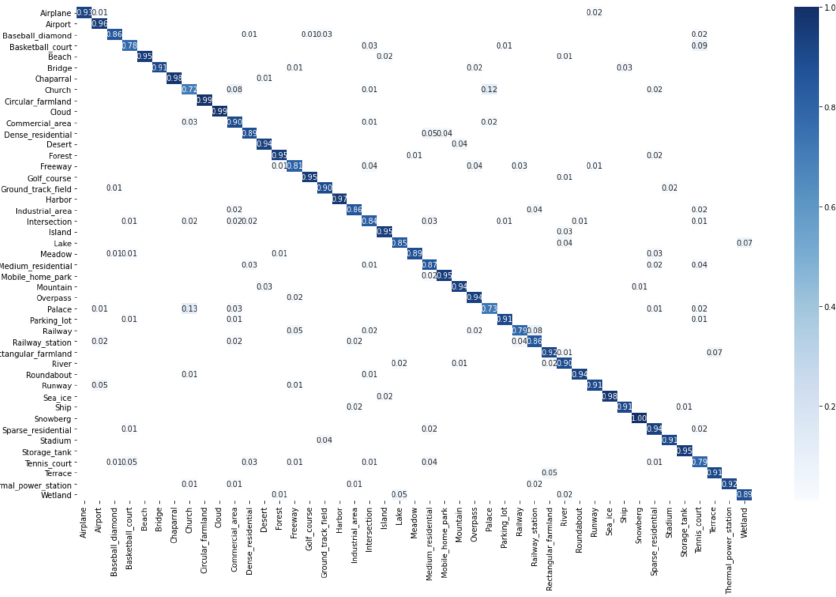
Figure 15. Confusion matrix of our method under the10% training ratio and 90% of features on the NWPU data